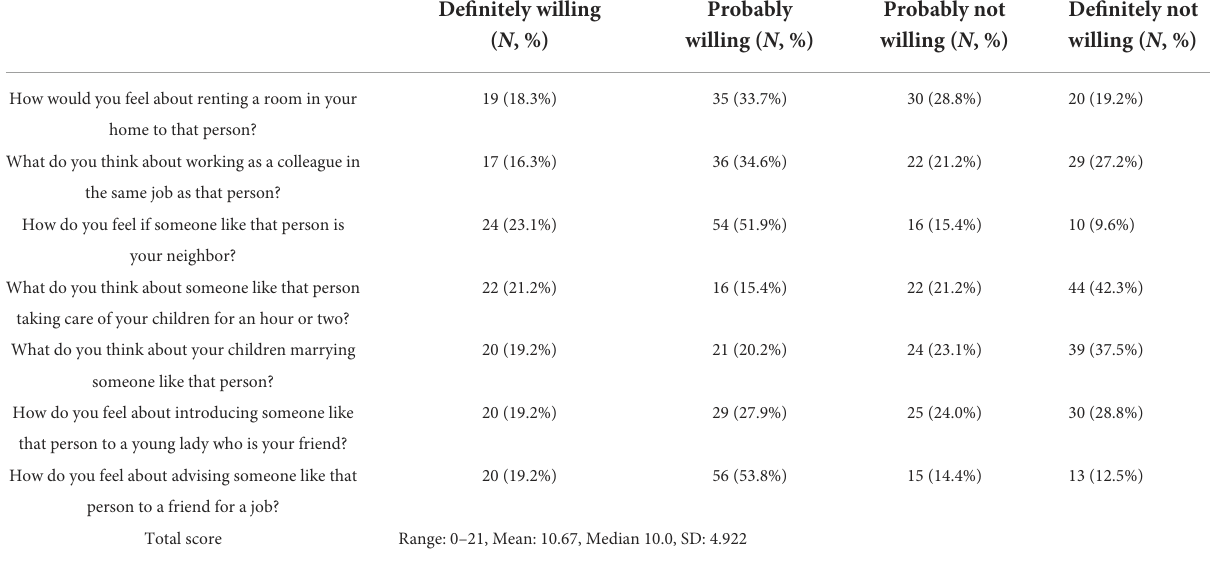
TABLE 3 Items and total scores of the Social Distance Scale (SDS).